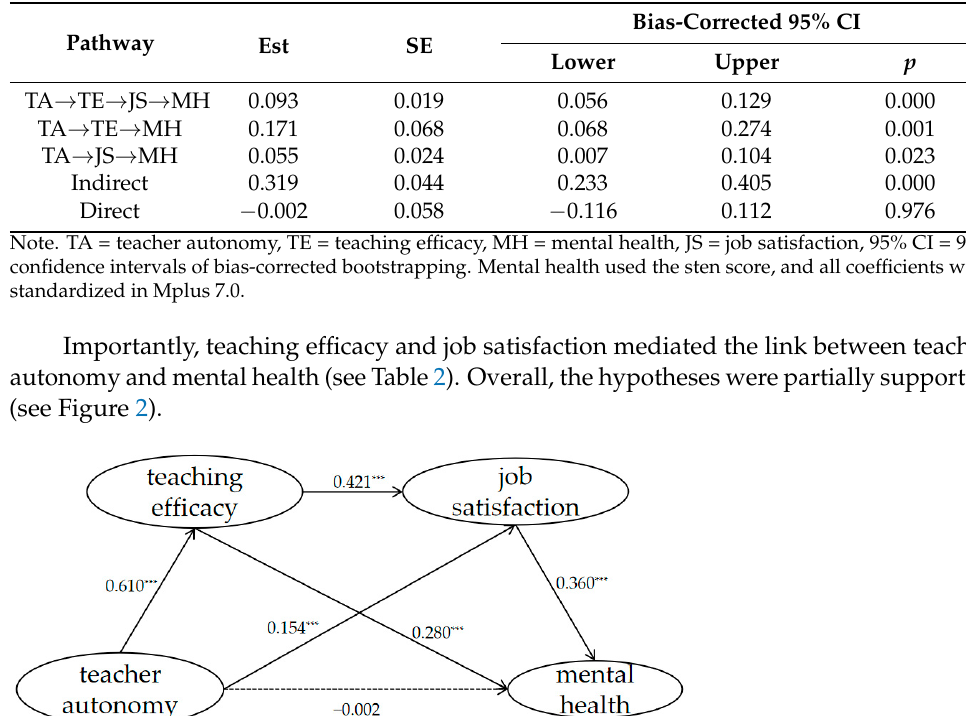
Table 2. Estimated and standard errors for the serial mediation model.